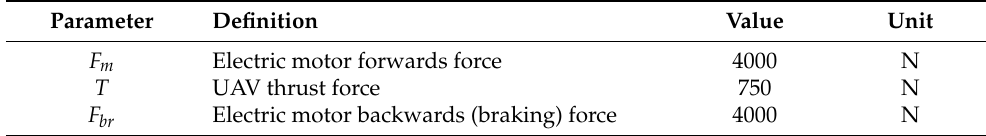
Table 4. The numerical values of F m , T and F br